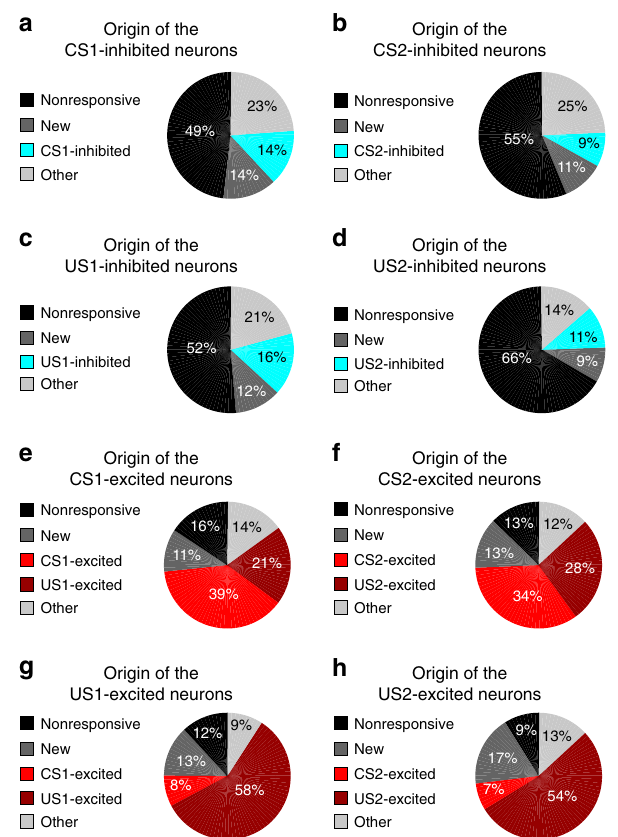
Fig. 4 The origin of post-learning CS-responsive and US-responsive neurons. a – d For the BLA neurons showing inhibitory responses to CS1 ( a ), CS2 ( b ), US1 ( c ), or US2 ( d ) at the post-learning stage, the majority of